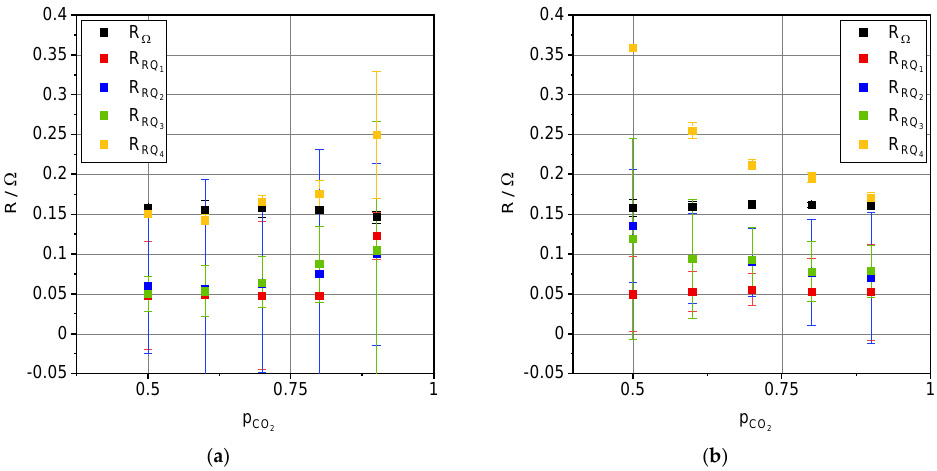
Figure 9. Resistances with respect to the CO 2 partial pressure at 800 °C and ( a ) OCV and ( b ) 0.35 A·cm −2 .